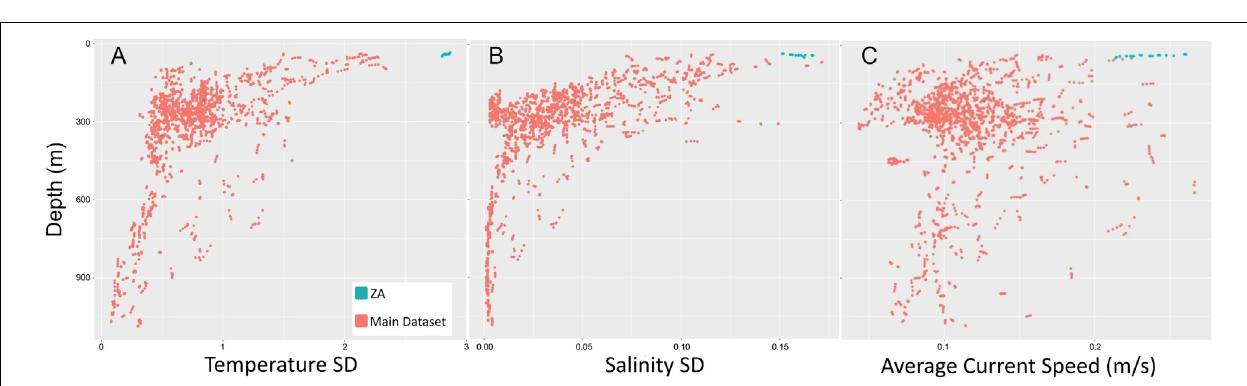
FIGURE 4 | Plots showing the distinct conditions present at the Spitsbergenbanken sample sites (ZA) relative to the main dataset. (A) Temperature. (B) Salinity. (C) Average current speed. Subsequently, the ZA group was removed from the main analysis to better characterize communities found in more typical